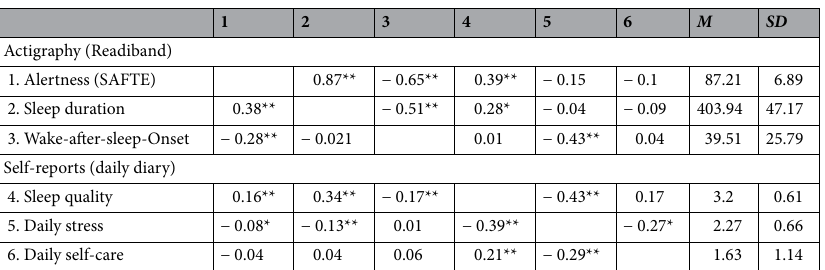
Table 2. Descriptive statistics and correlations of daily alertness, sleep, and well-being variables. Spearman’s non-parameteric correlations across days. Day-level correlations appear below the diagonal ( N days = 168–204), while person-level correlations appear above the diagonal ( N persons = 50). *p < 0.05; **p <